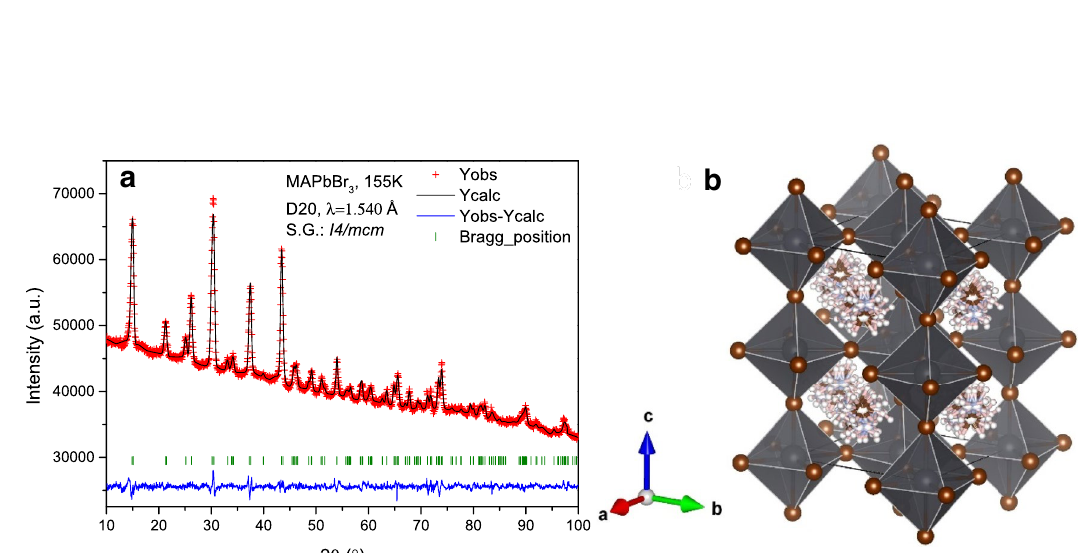
Figure 7. ( a ) Observed (crosses) calculated (black line) and difference (blue line) profiles after the Rietveld refinement from NPD data at 155.6 K, corresponding to the tetragonal ( I4/mcm ) symmetry. ( b ) View of the tetragonal unit-cell of the corresponding crystallographic